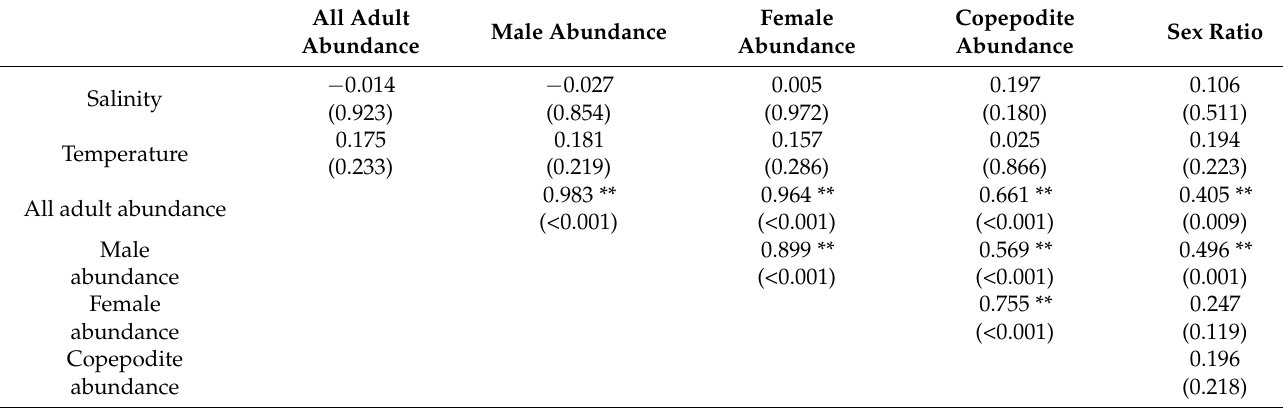
Figure 7. The abundance of all adults ( a ), males ( b ), females ( c ), and copepodites ( d ) of Temora turbinata among three seabed-depth zones from June 2018 to June 2019. Abundance of all adult males and females, the copepodites, and the sex ratio (male/female) of T. turbinata were not significantly correlated with salinity and seawater temperature ( p > 0.05) (Table 3). The abundance of all adult T. turbinata was significantly positive correlated with sex ratio (r = 0.405, p = 0.009). It is worth noting that there was a significantly positive correlation between the abundance of females and the abundance of copepodites (r = 0.755, p < 0.001), whereas this was not significantly correlated with sex ratio (r = 0.247, p = 0.119) (Table 3). Table 3. Correlation results of all adult abundance (individuals m − 3 ), male abundance, female abundance, copepodite abundance, and sex ratio (male/female) according to Pearson’s correlation analysis. The value represents the correlation (r), and the value in parentheses represents p